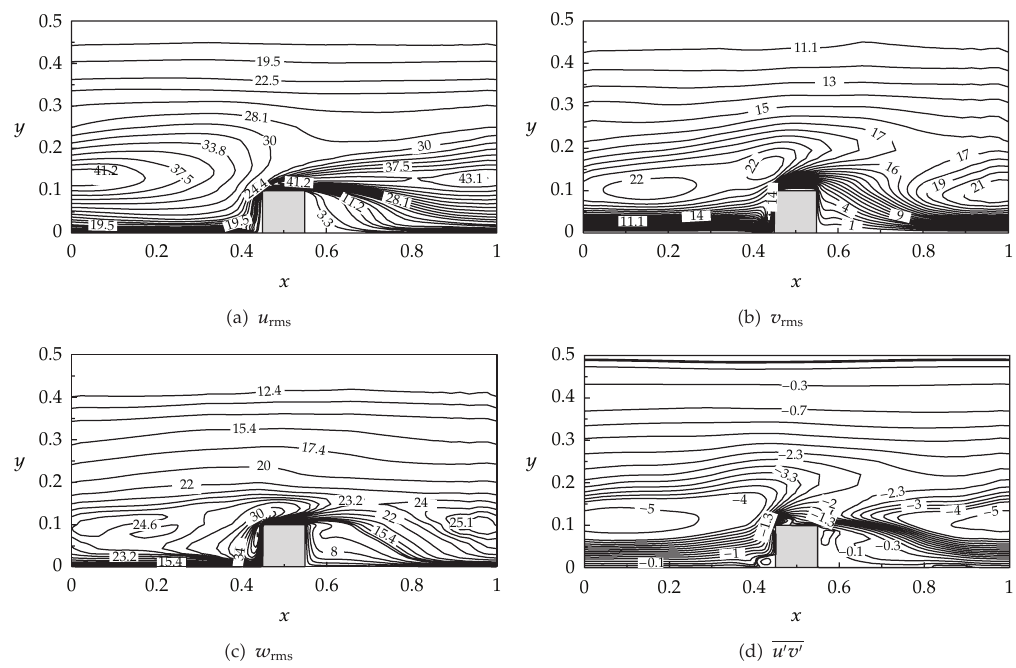
Figure 11: Distribution of resolved turbulent quantities (cid:2) a (cid:3) u rms (cid:2) × 100 (cid:3) , (cid:2) b (cid:3) v rms (cid:2) × 100 (cid:3) , (cid:2) c (cid:3) w rms (cid:2) × 100 (cid:3) , and (cid:2) d (cid:3) u (cid:3) v (cid:3) (cid:2) × 100 (cid:3) at center plane (cid:2) z (cid:8) 0 . 5 (cid:3) .